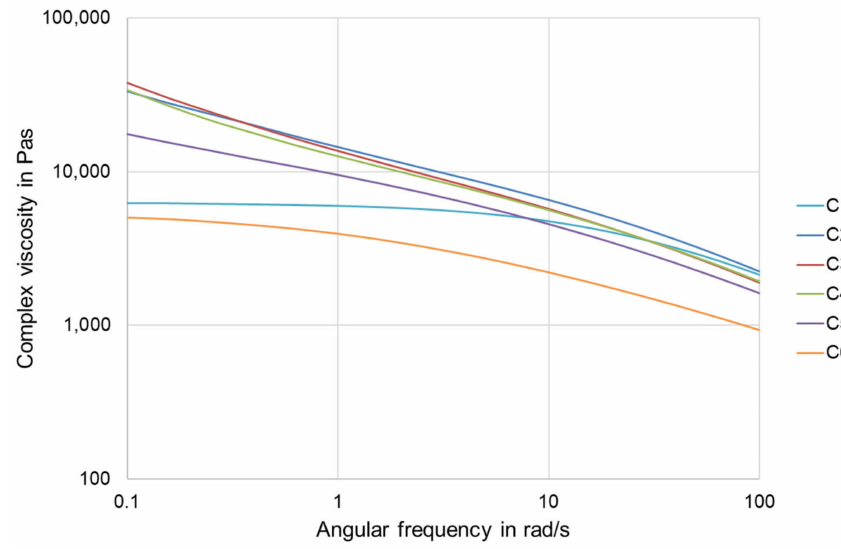
Figure 5. Complex viscosity of the compounds as a function of the angular